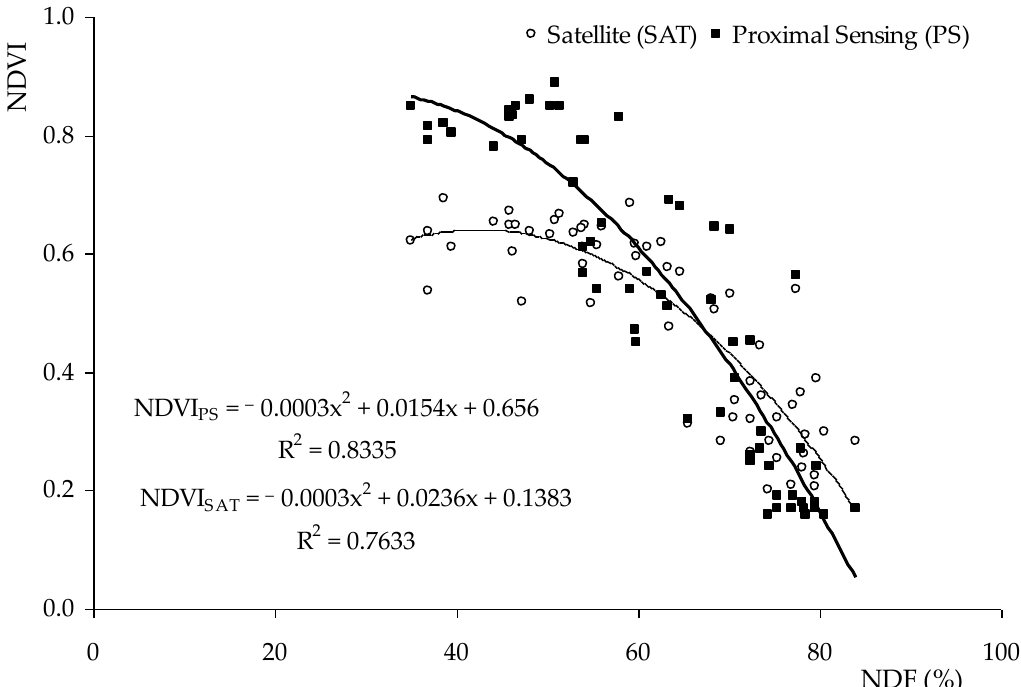
Figure 12. Correlation between vegetation index values (obtained by proximal sensor, NDVI PS ; and by satellite, NDVI SAT ) and pasture neutral detergent fiber (NDF), in the set of monthly sampling dates (between February and June 2017).